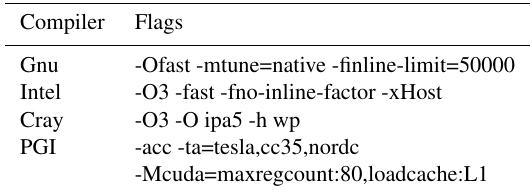
Table 2. The compiler flags used in this